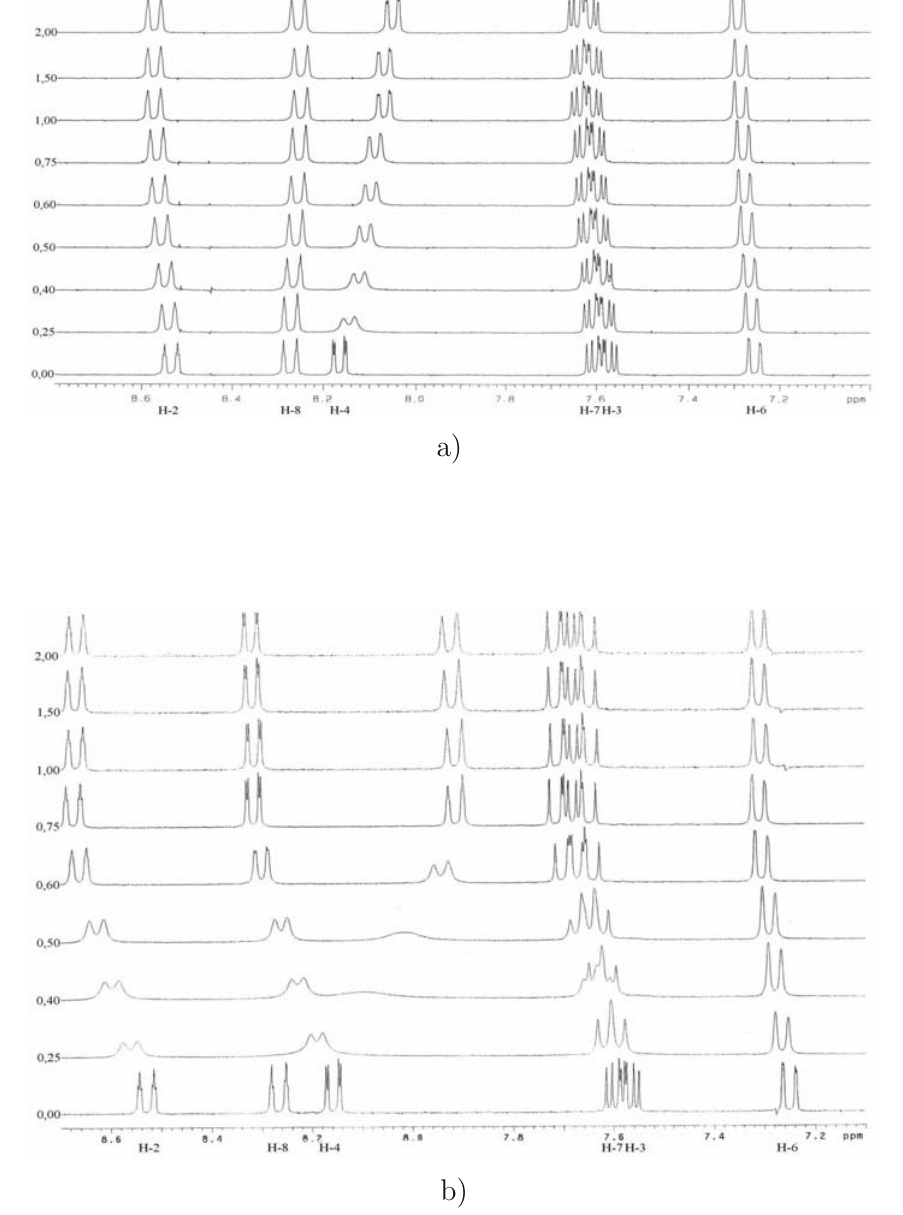
Fig. 5 1 H NMR spectra of the aromatic region of A18C6-Dns as the function of metal/ligand ratio with various ions: a. A18C6-Dns + Mg 2+ ; b. A18C6-Dns + Ca 2+ ; c. A18C6-Dns + Sr 2+ ; d. A18C6-Dns + Ba 2+